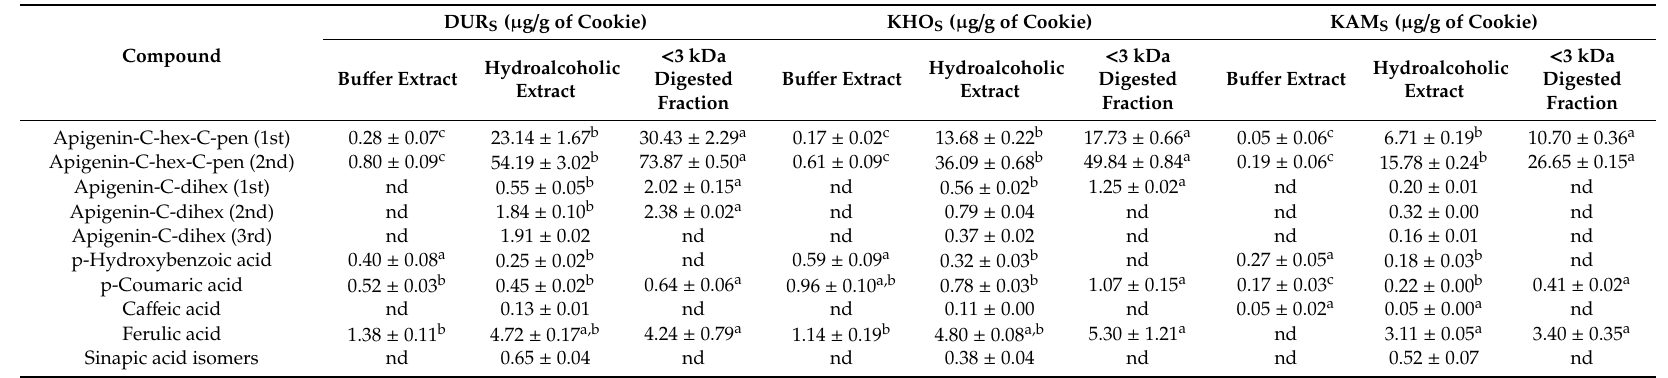
Table 2. Concentration of the main free PCs in the experimental cookies prepared using standard fermentation. Values are expressed as mean values ± SD ( n = 4 for extracts, n = 3 for digested samples). The statistical analysis was performed using one-way ANOVA followed by Tukey’s honest significant di ff erence (HSD) test. For each cookie type, di ff erent letters in the same row indicate statistical significance ( p < 0.05).